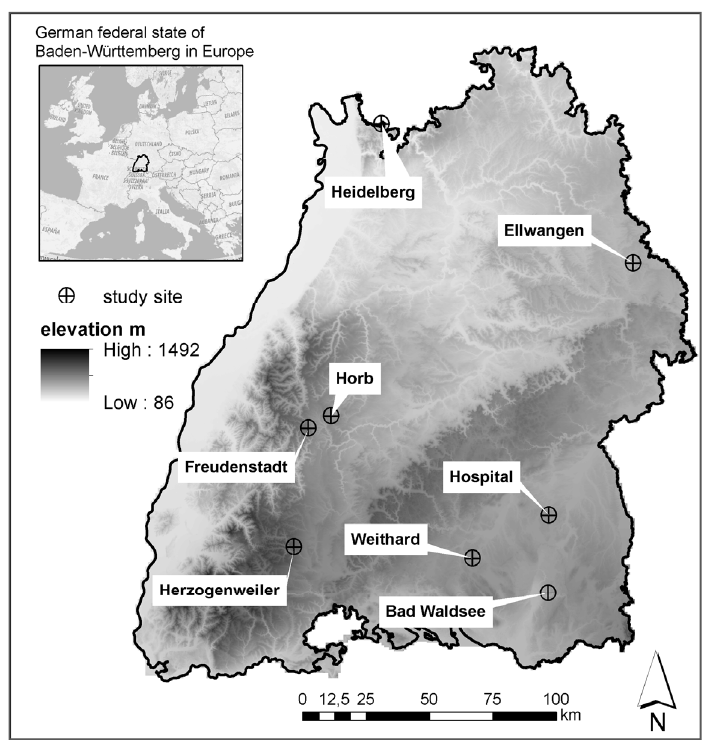
Figure A 1. Study site location. Figure A1. Study site